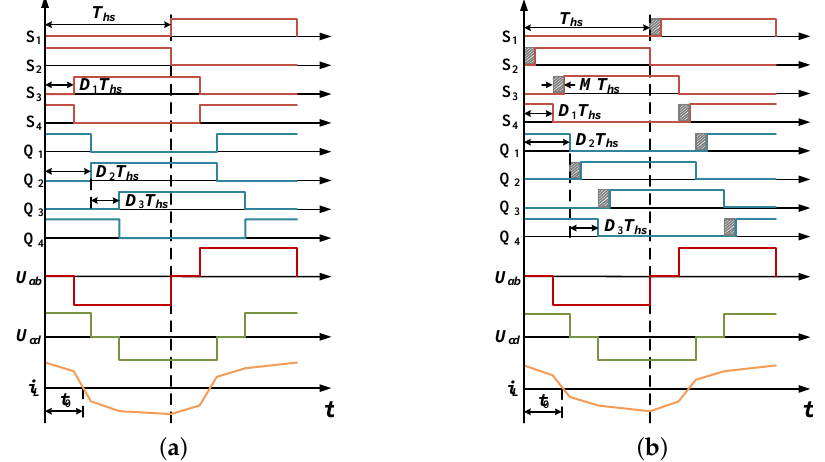
Figure 2. Typical waveforms of DAB converter: ( a ) ideal triple-phase-shift (TPS) control; and ( b ) actual TPS control with dead